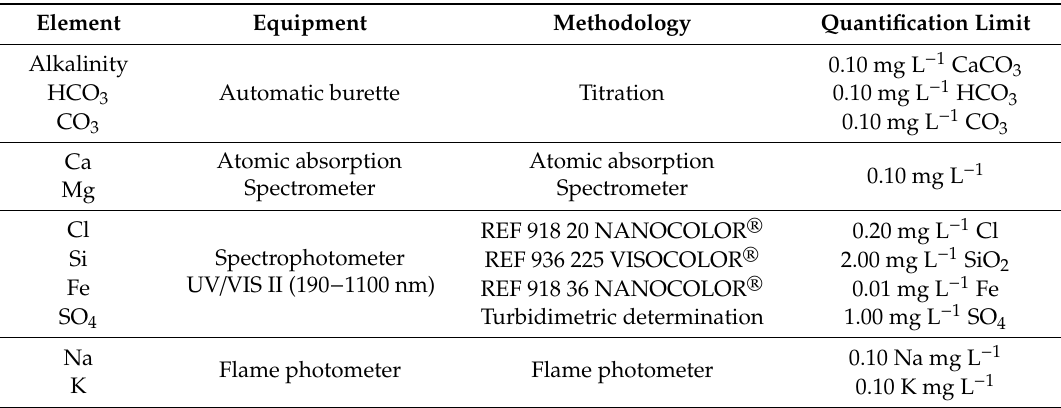
Table 1. Equipment and methodologies used for water